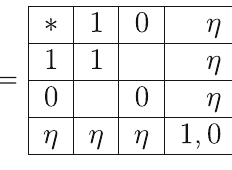
Fig. 3 Fusion rules of Jordan type